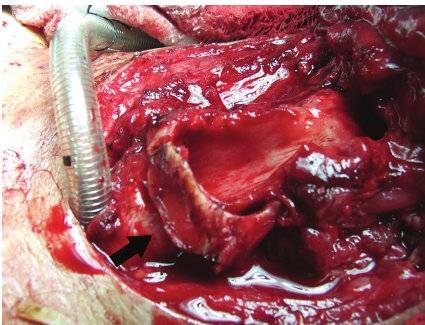
Figure 2: Using thyroid cartilage for cricoid reconstruction (arrow) (before suturation).